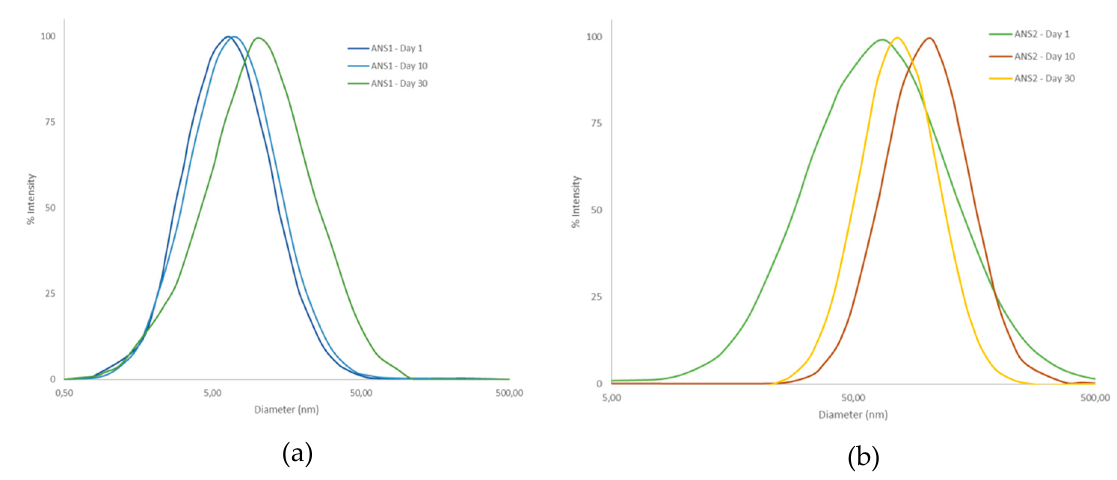
Figure 9. Particle size distribution curves of the systems ( a ) ANS1 and ( b ) ANS2.